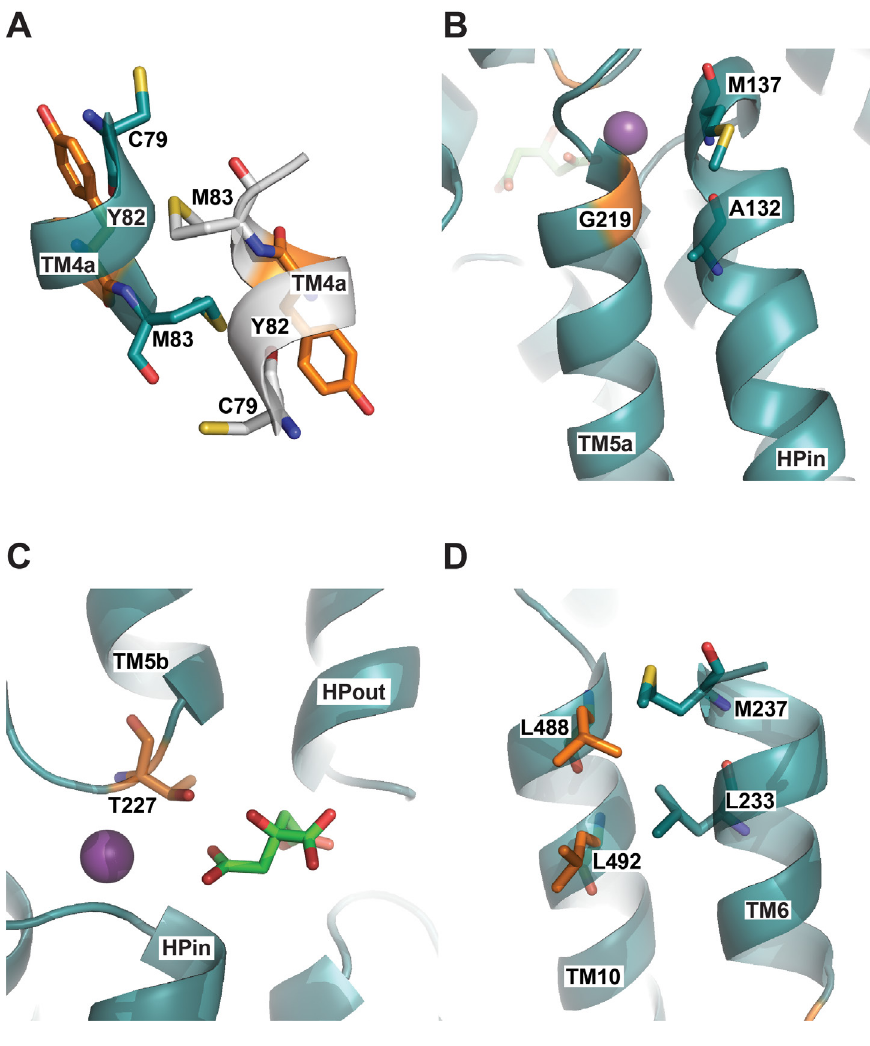
Figure 6. Homology model of hNaCT showing the location of the point mutations. (A) Y82 is located in TM4, (B) G219 (TM5a), (C) T227 (TM5b) and (D) L488 and L492 (both lo- cated in TM10). In all panels, the transmembrane helices are shown as cyan cartoons; key amino acids represented by sticks with the mutated residues colored in orange. The purple sphere in panels (B) and (C) represents the sodium ion that binds the Na1 binding site. Citrate is shown in green sticks in panel